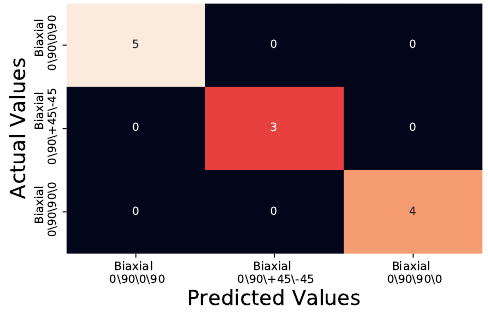
Figure 6. Confusion matrix for testing group samples MSE when compared to KDE / t